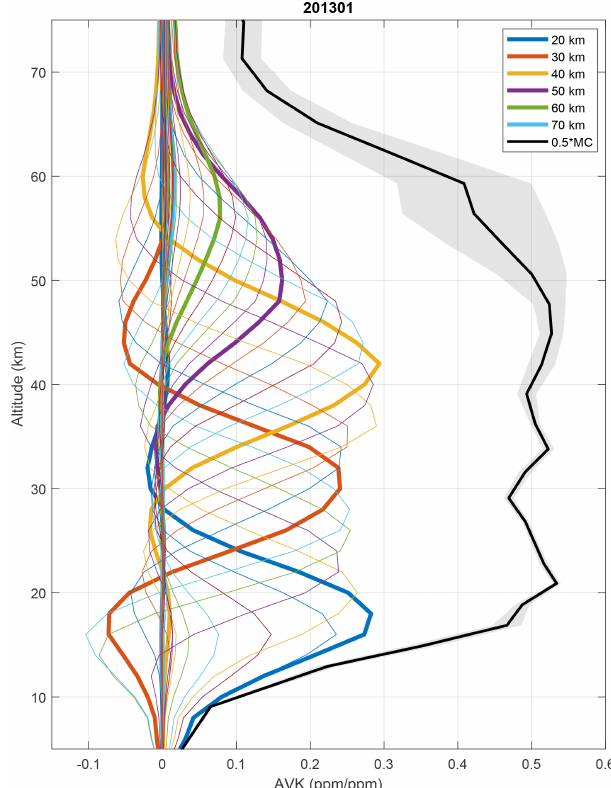
Figure 1. Mean values of Payerne MWR averaging kernels in parts per million per part per million and measurement contribution ( × 0 . 5) for January 2013. The shaded area represents the standard errors of the